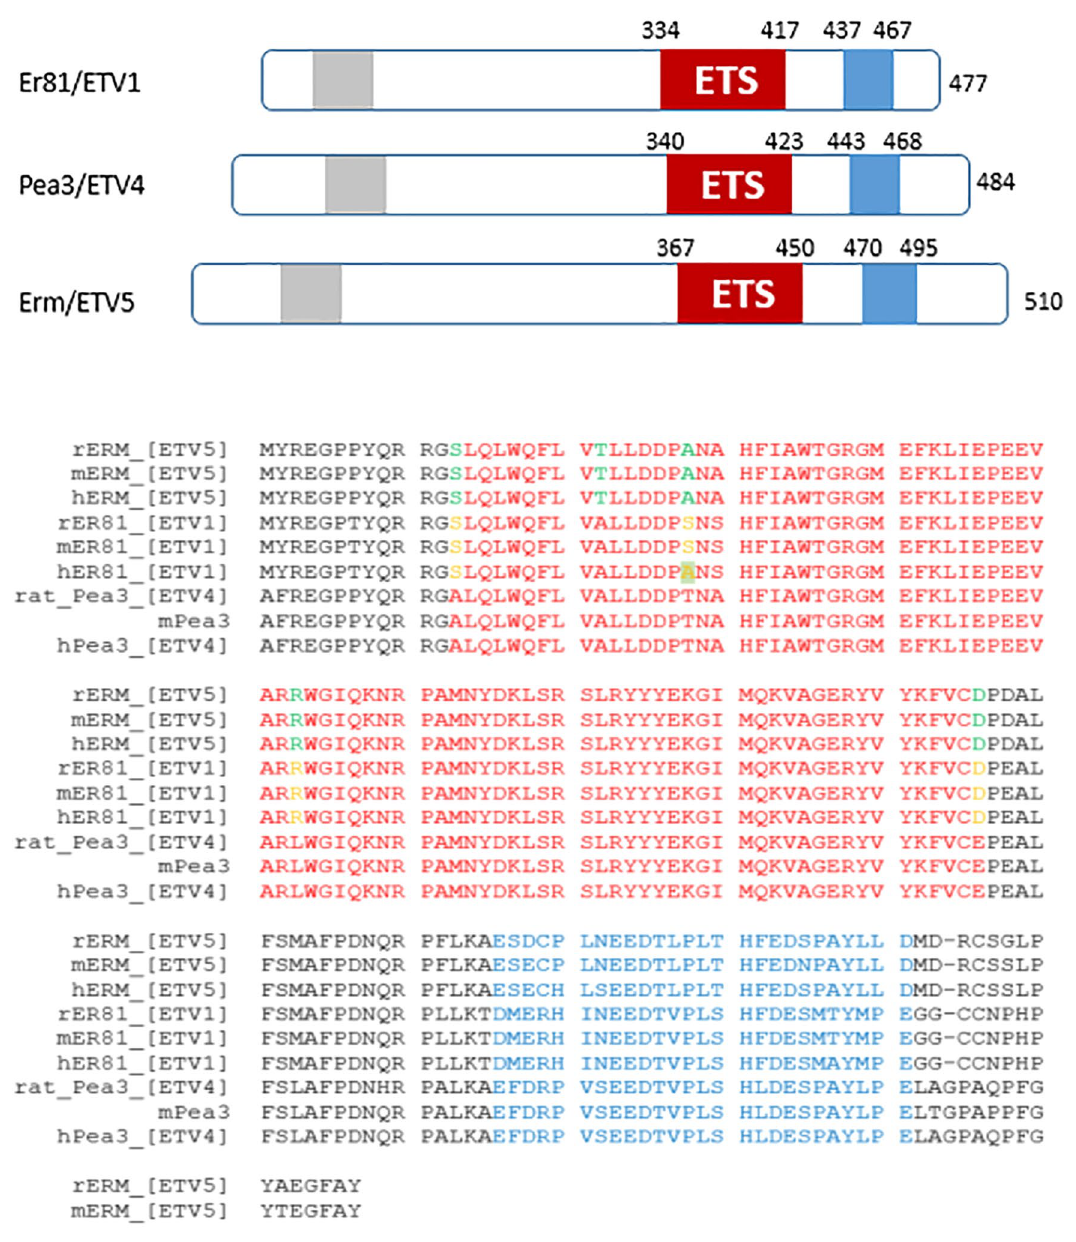
Figure 1. Schematic comparison of Pea3 family members’ domain structure and primary sequence of a region encompassing the ETS domain and the C terminal transactivation domain. Upper panel: Pea3 family members Er81/ETV1, Pea3/ETV4, and Erm/ETV5 have their DNA binding domain, the ETS domain, towards the C terminal (red box); all three members also contain two transactivation domains on each terminus (grey and blue boxes). Lower panel: Primary sequence of the region encompassing ETS domain (red font) and C terminal transactivation domain (blue font) across species ( r rat, m mouse, h human); the ETS domain is well-conserved and the key residues that show variability among family members and species are indicated by green (those specific for ERM), yellow (those specific for Er81) font